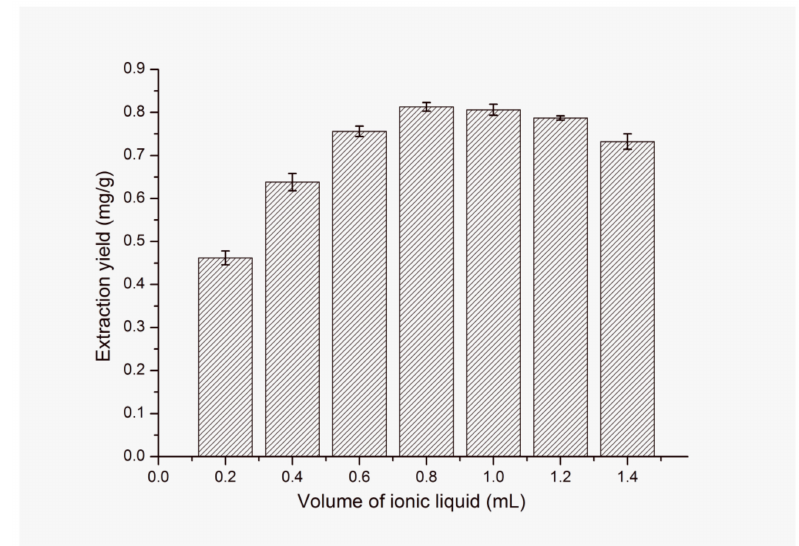
Figure 6. E ff ect of ionic liquid (IL) volume on extraction yield of FA. Sample amount, 50 mg; type of IL, [C 4 mim]NTf 2 ; extraction temperature, 60 ◦ C; solid–liquid ratio, 1:40 (g / mL); ultrasonic time, 9 min; centrifugal speed, 11,000 rpm; centrifugal time, 5 min.